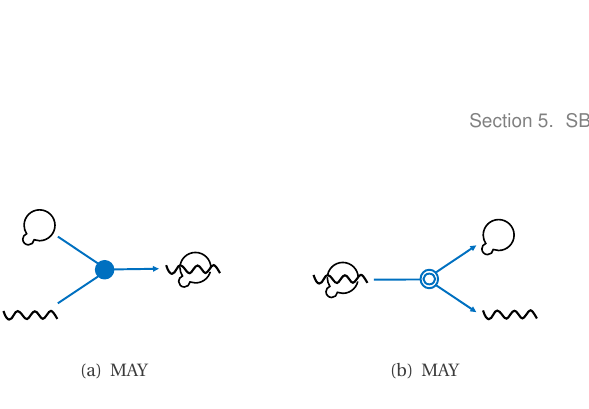
Figure 20: Examples of use of interaction nodes: (a) association of gRNA and Cas9 into an active CRISPR complex and (b) the dissociation of that complex.